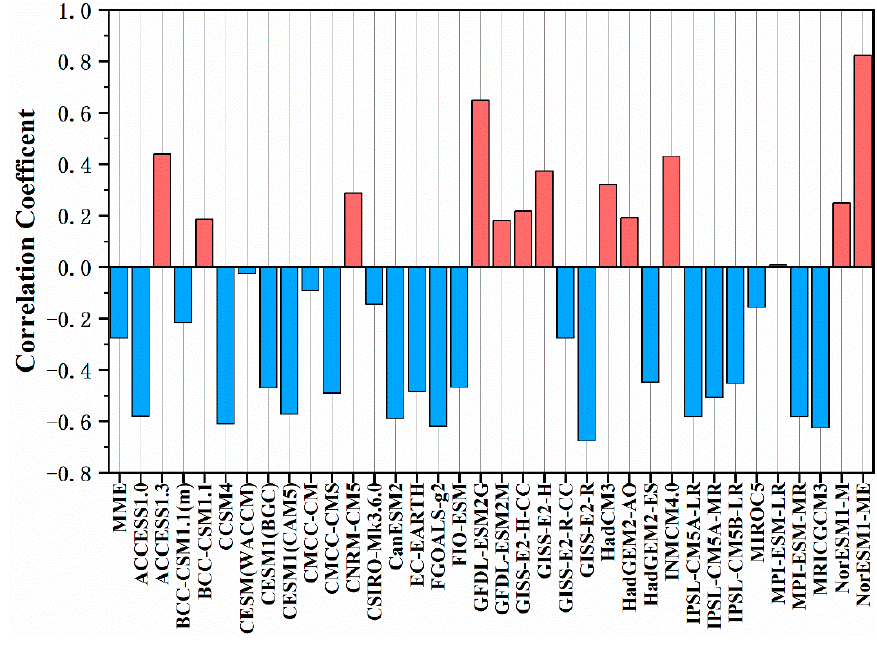
Figure 5. Spatial correlation coefficients of the observation records and simulations over the historical period of 1901–2005 based on the correlation between the PDO and CWT.